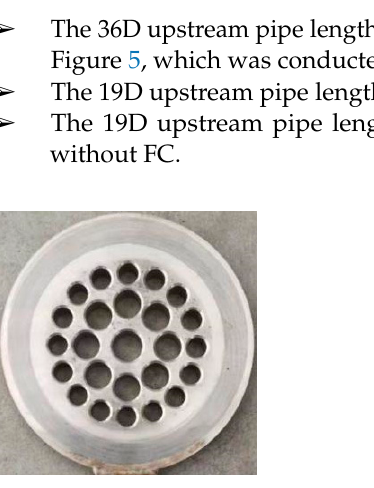
Figure 5. The flow conditioner. Figure 5. The flow